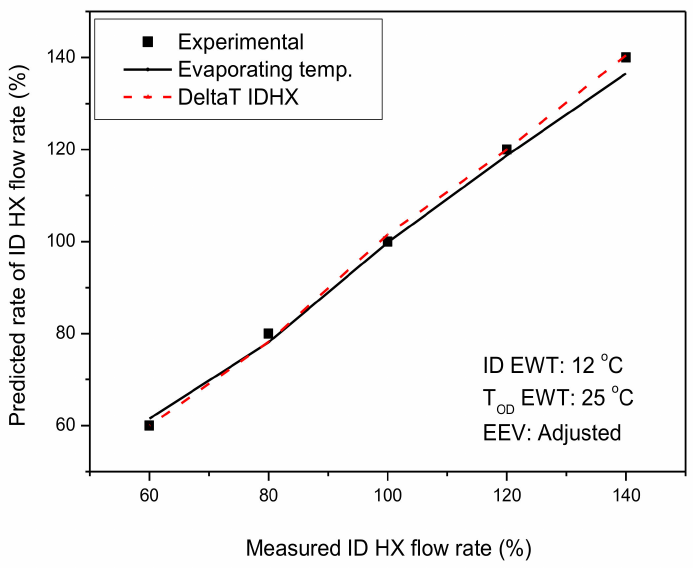
Figure 10. Comparison between predicted and measured evaporator SFFR at standard T OD